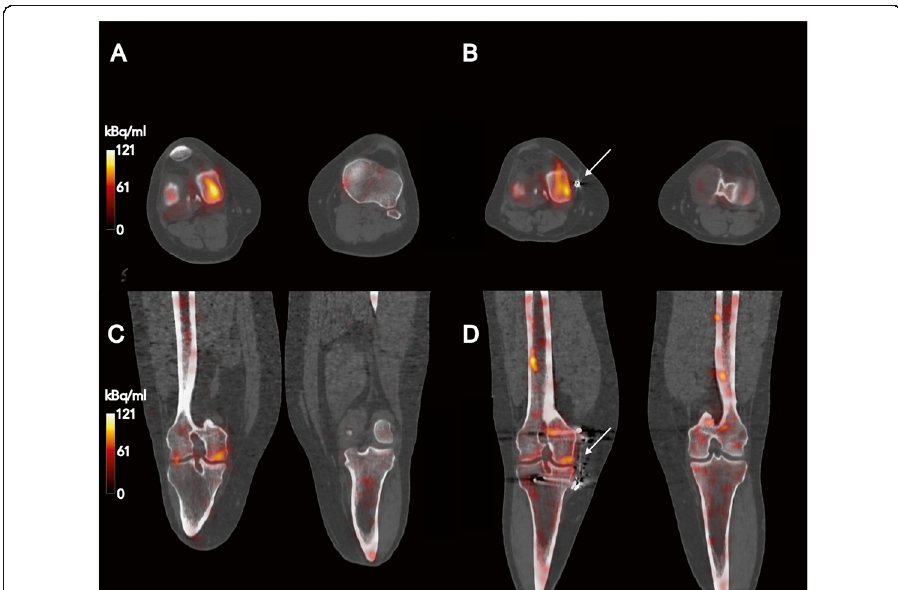
Fig. 2 a , c Pre-op SPECT-CT images from a patient (f, 36year, SPECT-CT: 8months pre-implantation) with a secondary gonarthrosis and b , d corresponding post-op imaging (10months post-implantation) exemplifying the effect from the examined knee implant system ( b , d : metal artifact labeled by arrow). Patient showing a constantly increased uptake at the medial condyle of the right femur after implantation of the load absorber (AC max, pre =118.6kBq/ml [SUV max =35.6] and AC max, post =110.89kBq/ml, [SUV max =32.9]). Accumulation patterns from bone turnover (pre/post) were windowed identically